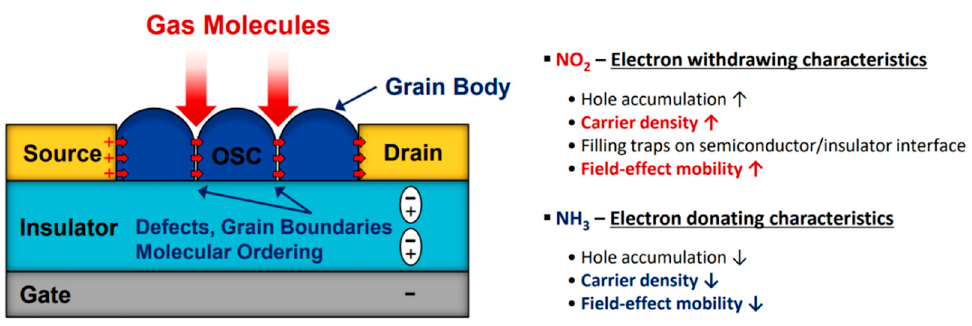
Figure 2. Gas sensing mechanism of organic-effect transistor gas sensors. OSC represents organic semiconductor.